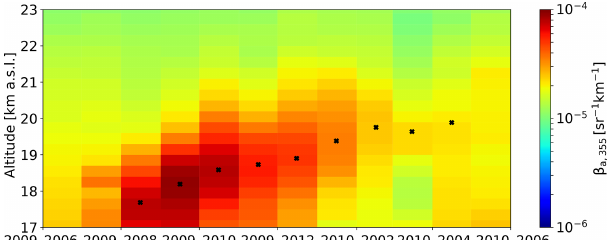
Figure 2. Monthly stratospheric aerosol backscatter corresponding to the Sarychev eruption plume derived from MLSOL. The center of the plume for each month is also shown (crosses, black).